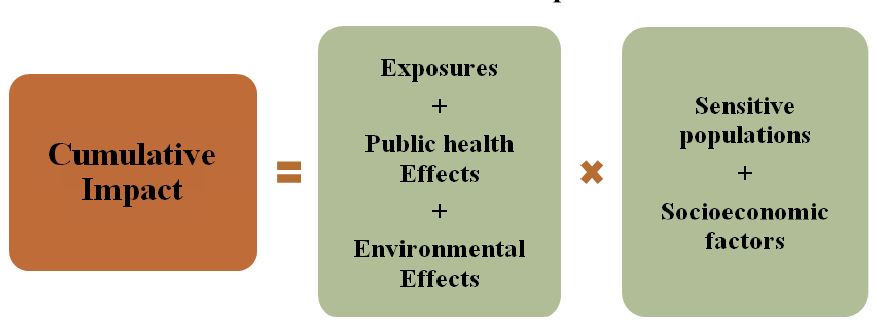
Figure 2. Formula for estimating relative cumulative impact.